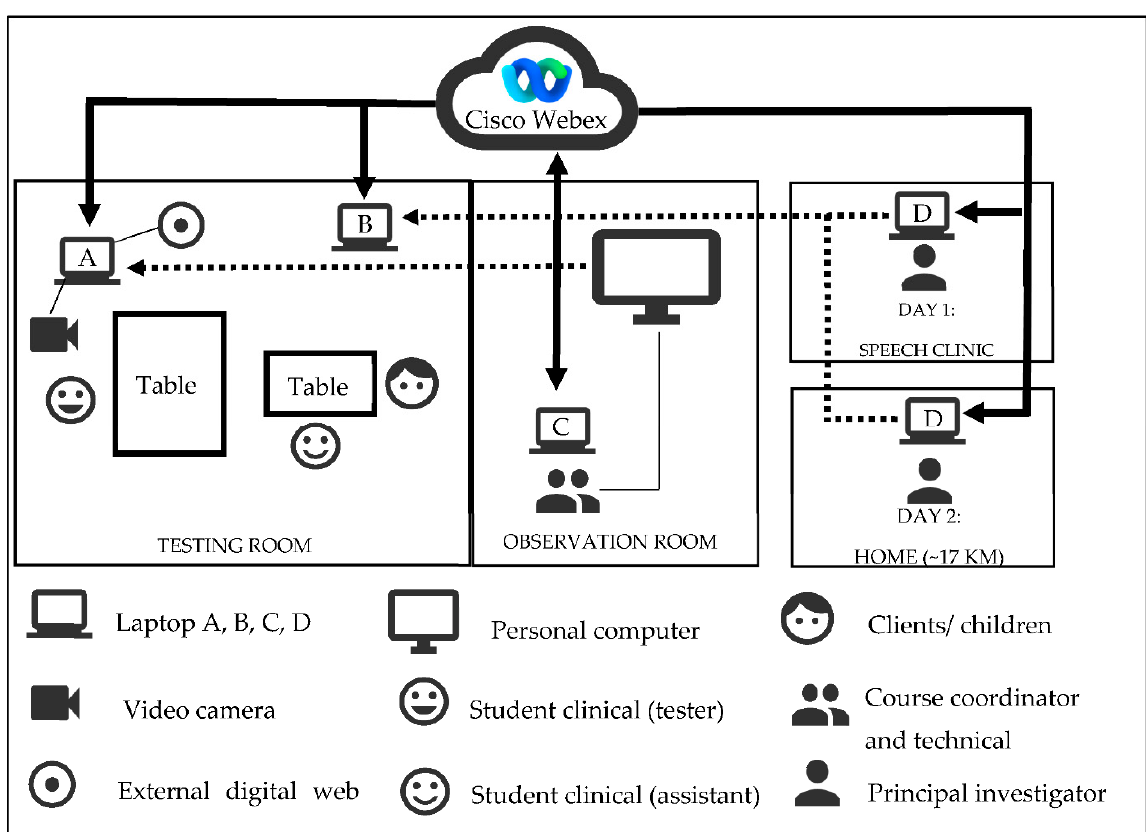
Figure A1. Audiology clinical examination setup.